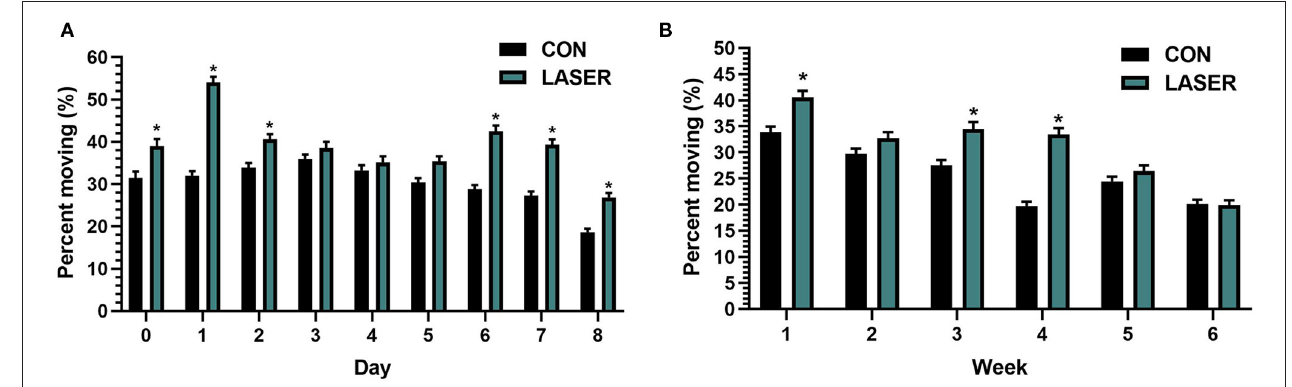
FIGURE 5 | Total percent of birds moving in LASER-enriched and CON pens over (A) d0–8 (enrichment × day LSMeans ± SEM) and (B) wk 1–6 (enrichment × week LSMeans ± SEM) a . Following the first d0–8, Thursdays of each week were selected for behavior video recording. a Bars denoted * indicate means that are significantly different within the same day/week ( P ≤